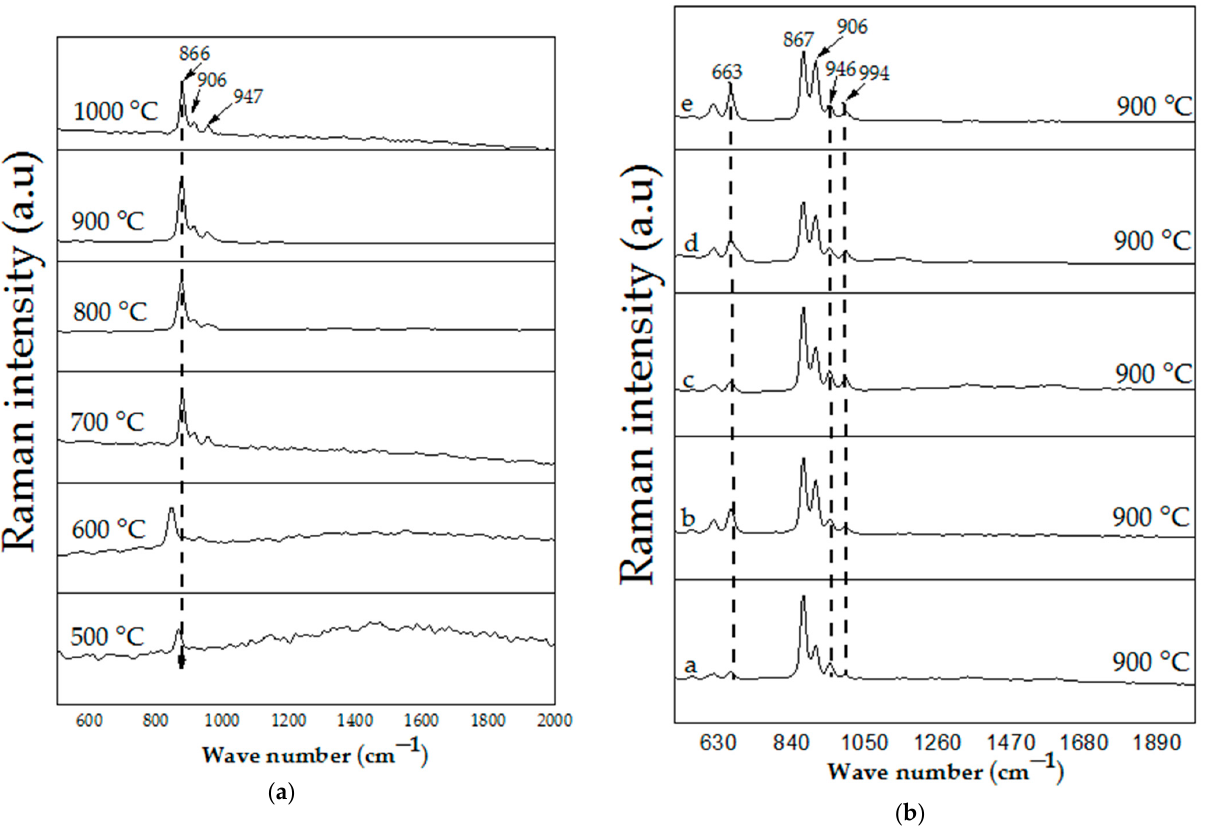
Figure 7. ( a ) Raman spectra of willemite NPs calcined at different temperatures; ( b ) FT–IR patterns of willemite with different Ce 3+ doping concentrations calcined at 900 °C; (a) 1 mol%, (b) 2 mol%, (c) 3 mol%, (d) 4 mol%, and (e) 5 mol%.